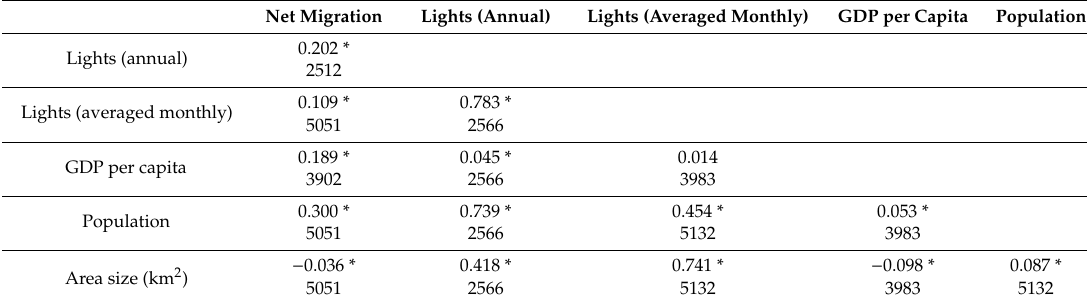
Table 1. Pairwise correlation coe ffi cients and the number of